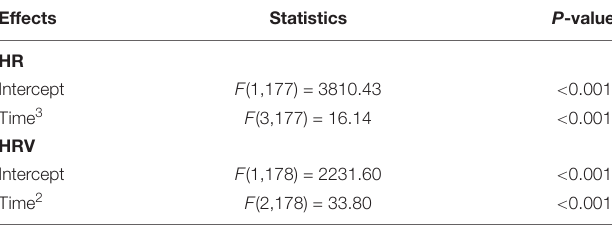
TABLE 2 | Summary of final model to predict HR and HRV in Study